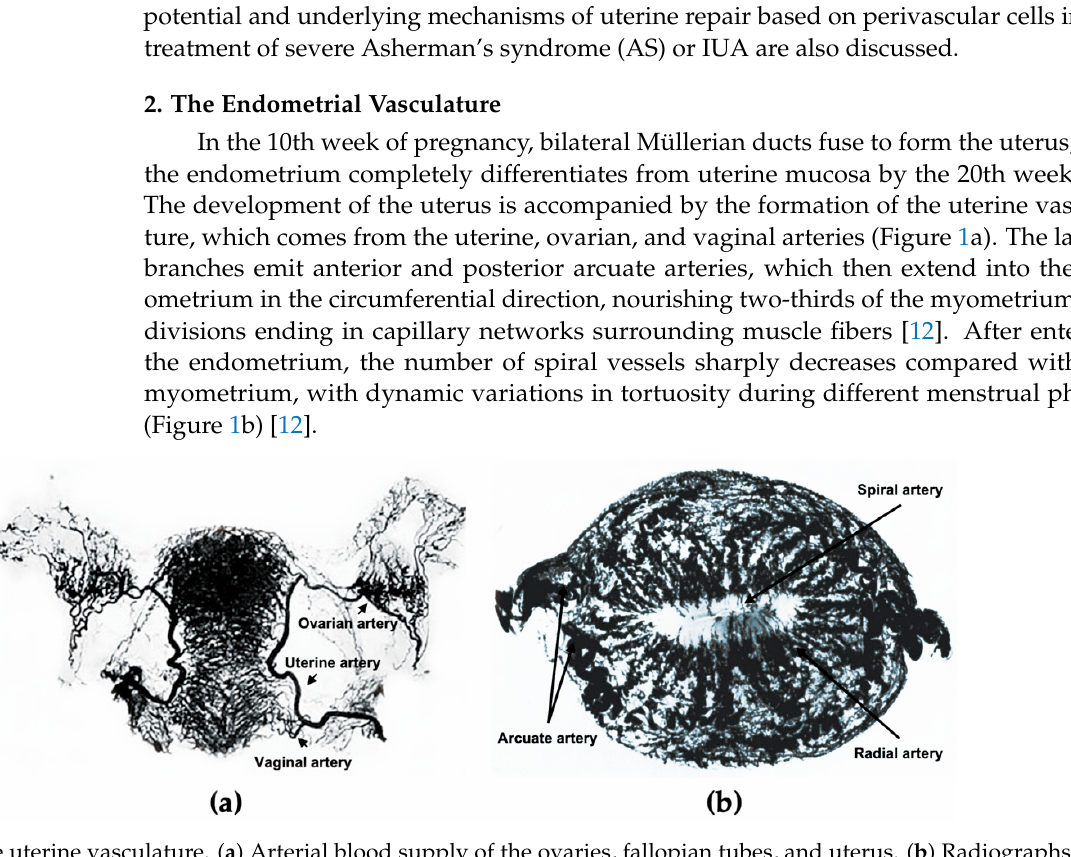
Figure 1. The uterine vasculature. ( a ) Arterial blood supply of the ovaries, fallopian tubes, and uterus. ( b ) Radiographs of the transverse slice of the uterus in the mid-secretory phase, showing its arterial vasculature. Figure 1a is edited from the figure by Norris, C.C., Clark, J.G., and Peters, D. Gonorrhea in Women . 1913 . Figure 1b is edited from the figure by Farrer-Brown, G., Beilby, J.O., and Tarbit, M.H. The Blood Supply of the Uterus. 1. Arterial Vasculature. J. Obstet. Gynaecol. Br. Commonw. 1970 , 77 , 673–681.